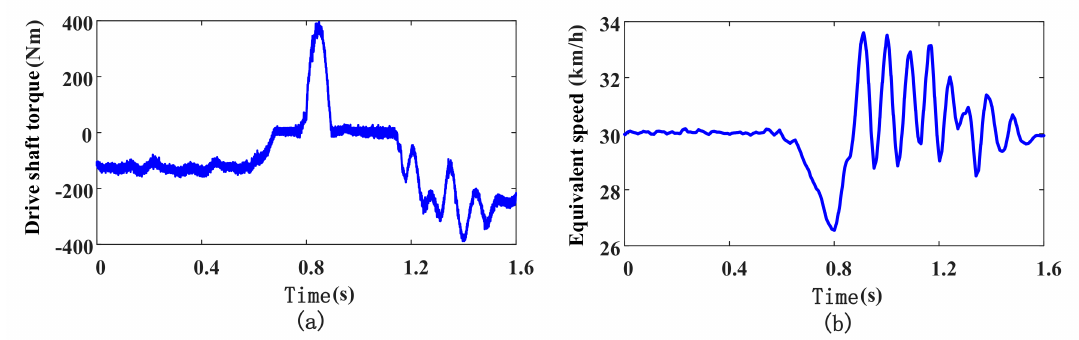
Figure 8. Driveshaft torque and equivalent vehicle speed of powertrain test bench system: ( a ) drive shaft toque; ( b ) equiva- lent speed.